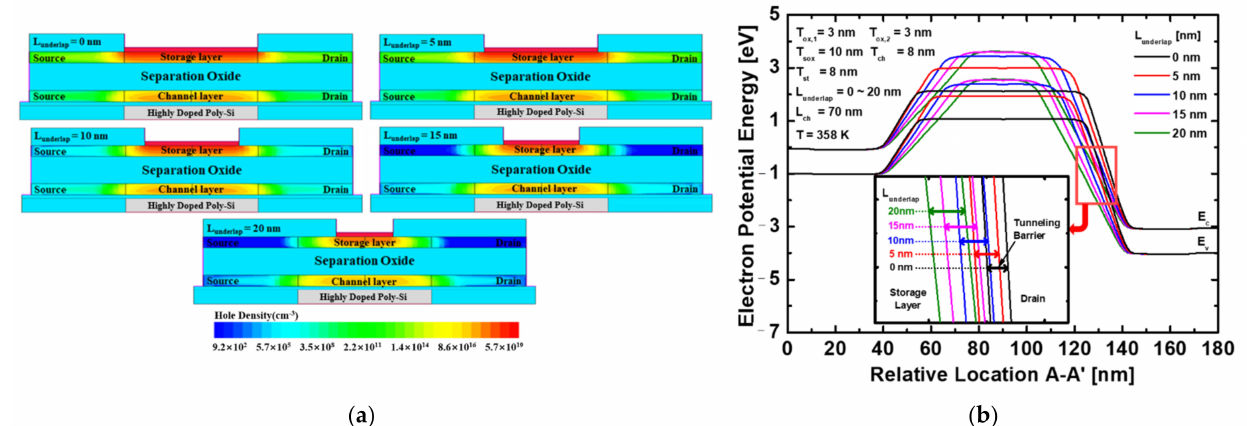
Figure 8. ( a ) Simulation profile of the proposed 1T-DRAM with different Lunderlap during hold “1” operation showing hole density. ( b ) Energy band diagram of the storage layer with different Lunderlap during program operation. The energy band is extracted 2 nm below top gate oxide.